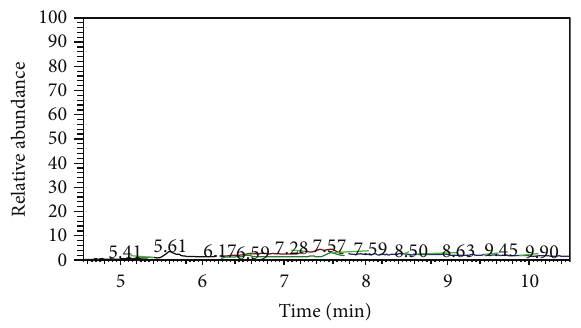
Figure 5: GC/MS chromatogram of fortified urine at 5 𝜇 g L −1 (a) and blank (b)